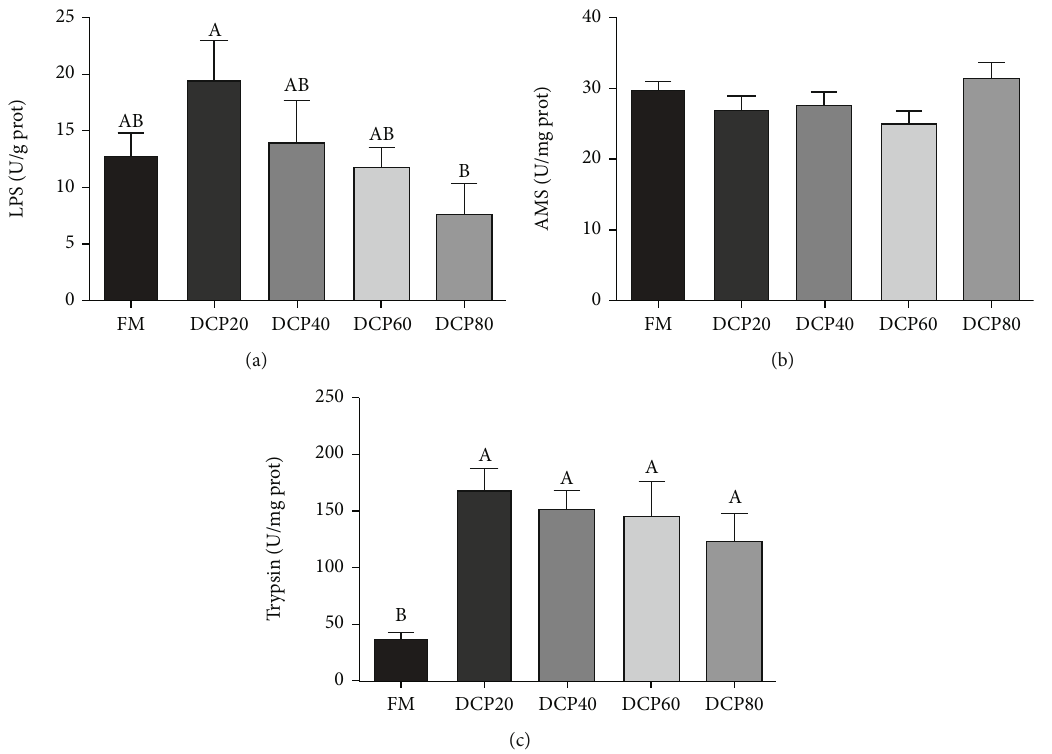
Figure 5: E ff ect of degossypolized cottonseed protein on intestinal digestive enzyme activities of juvenile fed the trial diets ( means ± SEM, n = 3 ). LPS: lipase; AMS: amylase. No repetition of letters in the equal index means signi fi cant di ff erences ( P < 0 : 05 ).